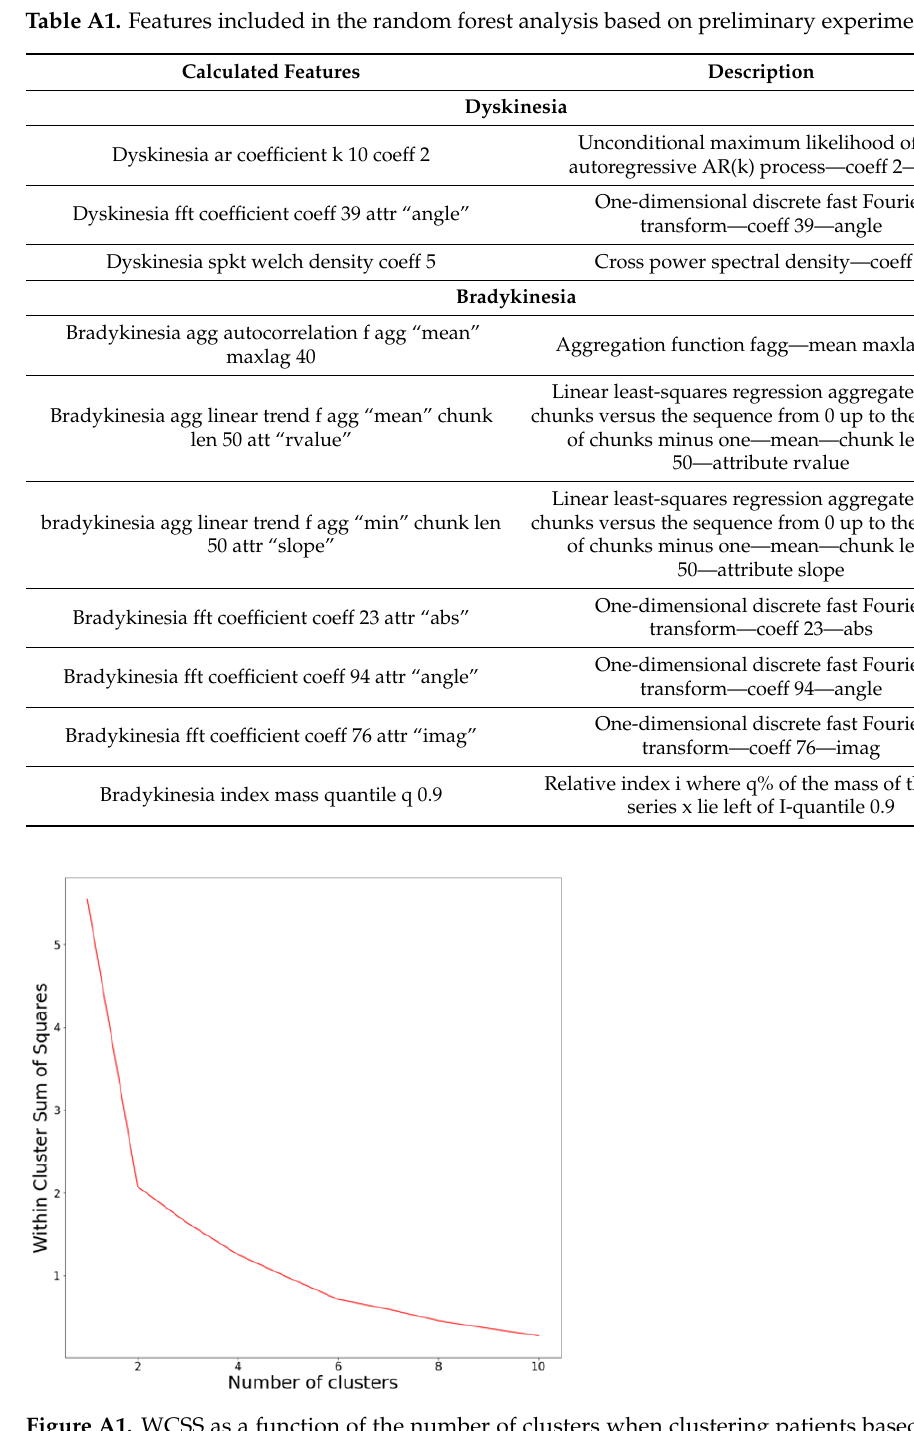
Figure A1. WCSS as a function of the number of clusters when clustering patients based on their best symptom control medication regimens between the two visits according to PKG’s summary dyskinesia and bradykinesia scores. The number of clusters is set to four, as a number towards the bottom of the “elbow” is considered best, but further increasing the number of clusters has been shown to reduce the model’s robustness.